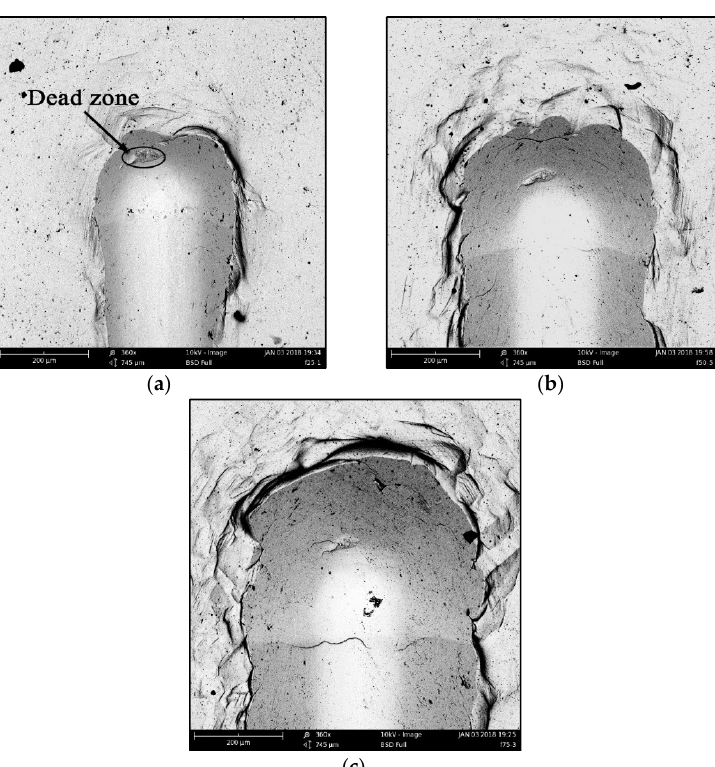
Figure 13. The topography of scratches at different depths. ( a ) Scratching depth = 25 μ m; ( b ) Scratching depth = 50 μ m; ( c ) Scratching depth = 75 μ m.